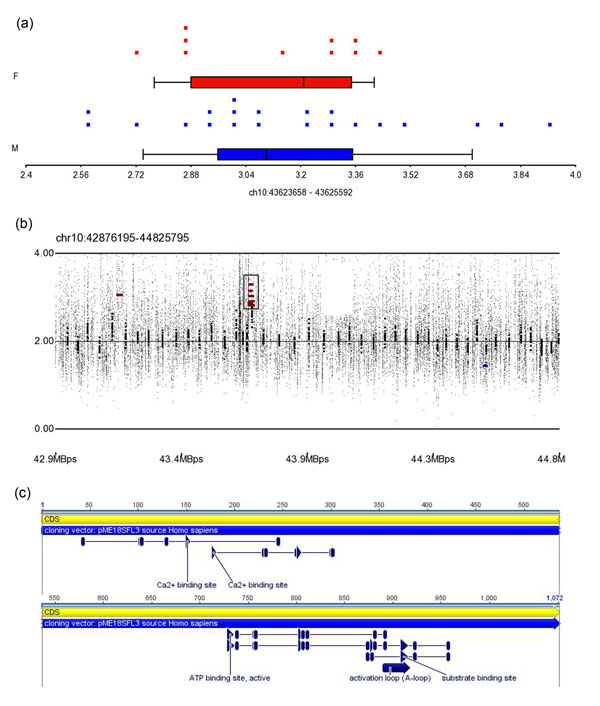
The CN state and SNP array profile graph of gain CNV region on 10q 11.21. (a) The distribution of CNs in the gain CNV region on 10q11.21. Blue and red dots indicate male and female patients, respectively; (b) SNP array profile for 10q11.21; the black box shows the location of this CNV region; (c) Characteristics and exon region of this gain CNV region in protein P07949.